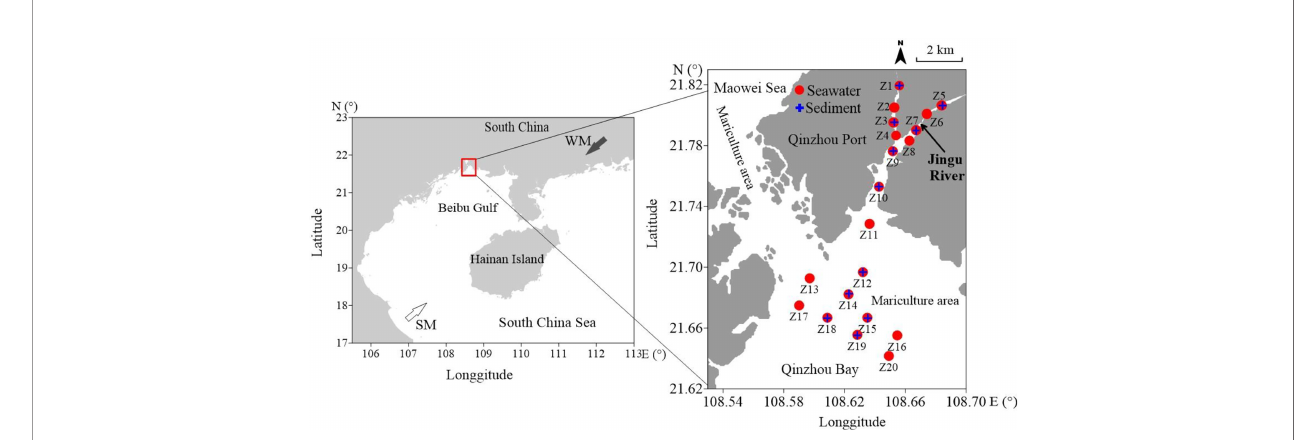
FIGURE 1 | Study area and the sampling stations in the estuarine and the adjacent sea in Qinzhou Bay. The red box in the left is the sampling area, the red dots in the right are the seawater sampling stations, and the blue crosses in the right are the sediment sampling stations. SM, summer monsoon; WM, winter